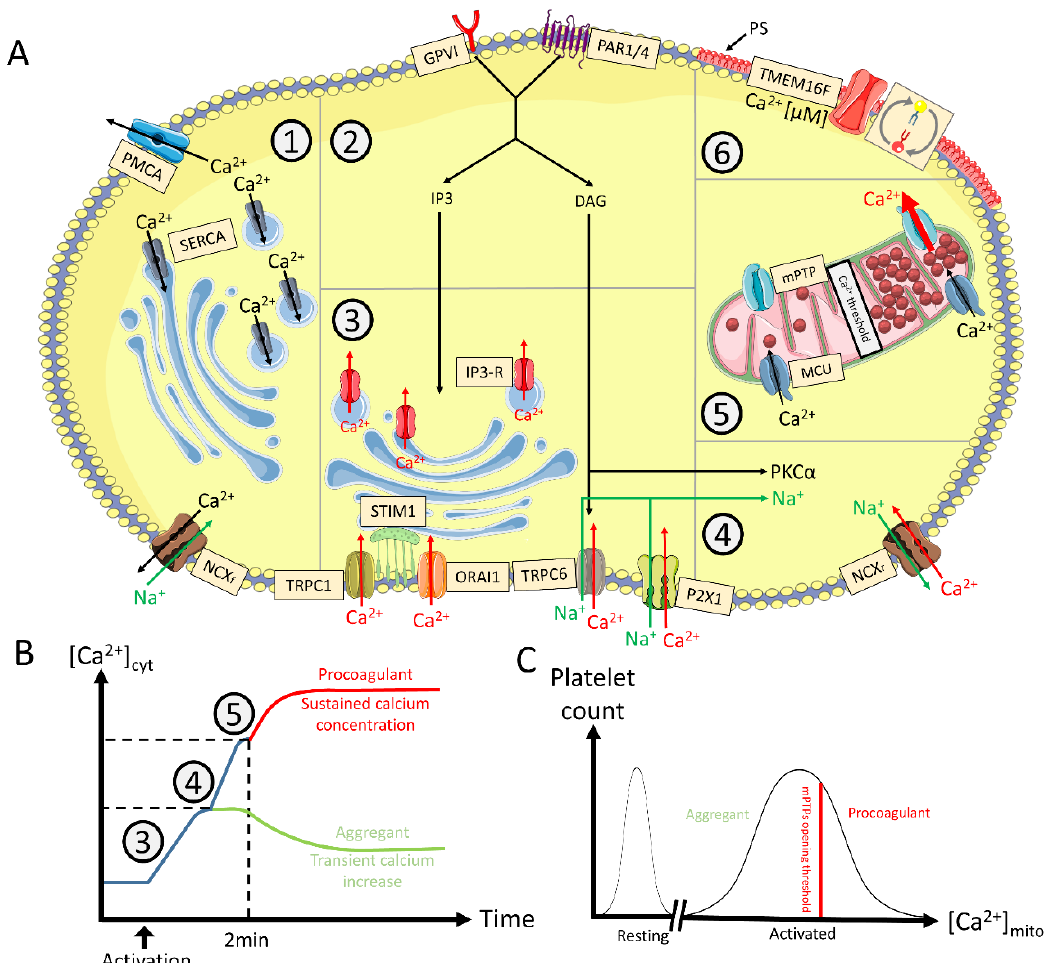
Figure 2. Calcium mobilization mechanisms and intracellular profile leading to procoagulant COAT platelets. Panel A. Cytosolic calcium regulation. 1. Downregulation : The intracellular level of cal- cium (Ca 2+ ) is negatively regulated (Ca 2+ in black) by PMCA and the forward mode of NCX (Ca 2+ efflux towards the extracellular space) respectively compartmentalized by SERCA in intracellular stores (granules, DTS) and MCU in mitochondria. 2. Initial activation : Engagement of GPVI (by collagen) and PAR1/4 (by thrombin) mediate IP3 and DAG production. 3. Internal Ca 2+ storage : IP3 triggers the release of Ca 2+ from the internal stores through its receptor while the stores are refilled by ORAI1 mediated by STIM1 (Ca 2+ sensor). TRPC1 is either agonist or storage depletion dependent and increases cytosolic Ca 2+ and sodium (Na + ) when activated. TRPC6 activation is mediated by DAG. ATP released from granules activates the P2X1 receptor increasing cytosolic Ca 2+ and Na + . 4. NCX reversing : Increased cytosolic Na + and PKC α contribute to the reverse mode of NCX. 5. Mito- chondrial permeation : Cytosolic Ca 2+ is transferred into mitochondria through MCU. At a given threshold, and in some platelets, mitochondrial Ca 2+ triggers mPTP opening, releasing an important amount of Ca 2+ in the cytosol. 6. PS exposure : Sustained micromolar levels of cytosolic Ca 2+ are nec- essary to activate low Ca 2+ -sensitive actors such as calpain and TMEM16F. The latter scrambles membrane phospholipids inducing the expression of PS in the outer part of the cytosplamic mem- brane. Panel B. Model of stepwise Ca 2+ mobilization . After initial [Ca 2+ ] cyt increase, some platelets do not trigger NCX reversing, and will remain aggregant decreasing their [Ca 2+ ] cyt (green). Other platelets undergo NCX reversing, thus further increasing [Ca 2+ ] cyt . Platelets become procoagulant (red) approx. 2 min after activation, when Ca 2+ concentrations in cytoplasm and mitochondria reach a threshold level to induce mitochondrial depolarization, supramaximal [Ca 2+ ] cyt , and subsequent PS exposure. Panel C. Mitochondrial Ca 2+ profile at the population level . The level of accumulated mitochondrial Ca 2+ depends on previous activation of the Ca 2+ mobilization sources following plate- let activation. Mitochondria of a platelet subpopulation accumulate enough Ca 2+ to open their PTPs and induce a procoagulant response in those platelets. The figure uses modified images from Servier Medical Art under a Creative Commons Attribution 3.0 Unported License (http://smart.servier.com,